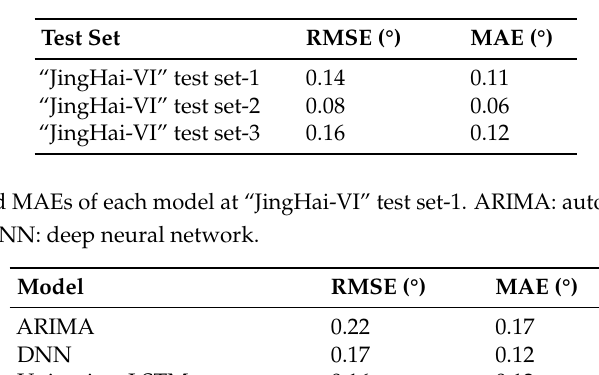
Figure 6. The prediction results of “JingHai-VI” by the proposed model: ( a ) test set-1; ( b ) test set-2; and ( c ) test set-3. Table 1. Root mean square errors (RMSEs) and mean absolute errors (MAEs) of the proposed model for “JingHai-VI”.